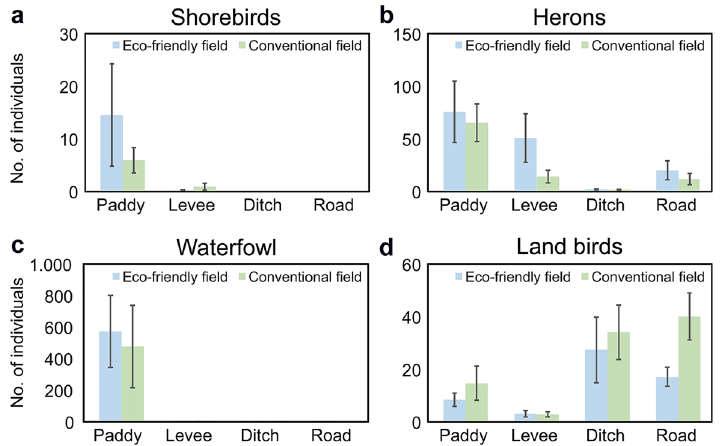
Figure 6. Average bird group abundance (( a ) shorebirds, ( b ) herons, ( c ) waterfowl, and ( d ) land birds) values in eco-friendly and conventional fields among habitat types (paddy, levee, ditch, and road). The sample size was 36, which is the number of surveys (once per month for 3 years, from January 2014 to December